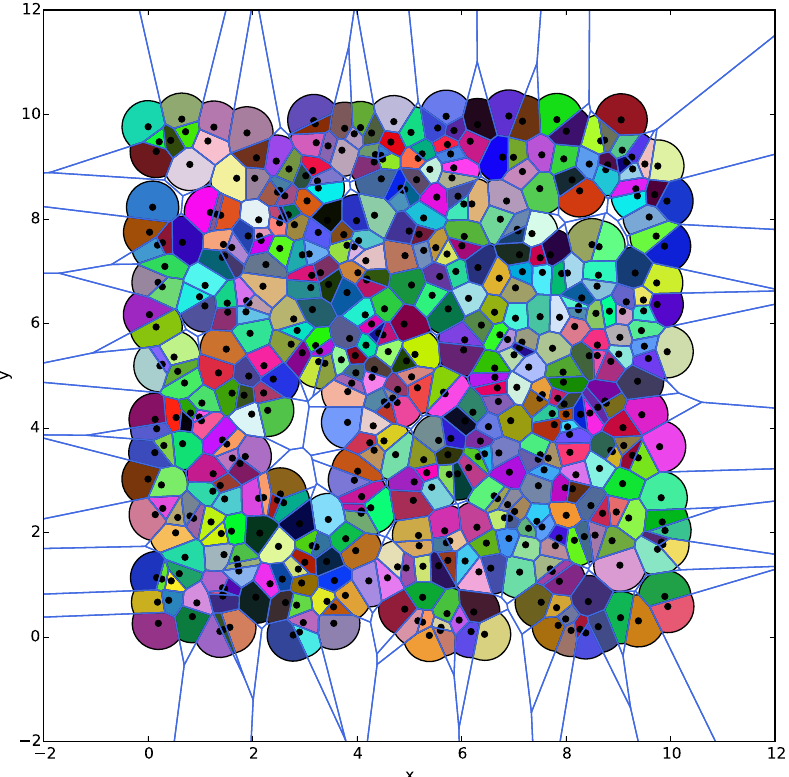
Figure 5. The comparison of the exact and r /2-limited Voronoi partition of the same